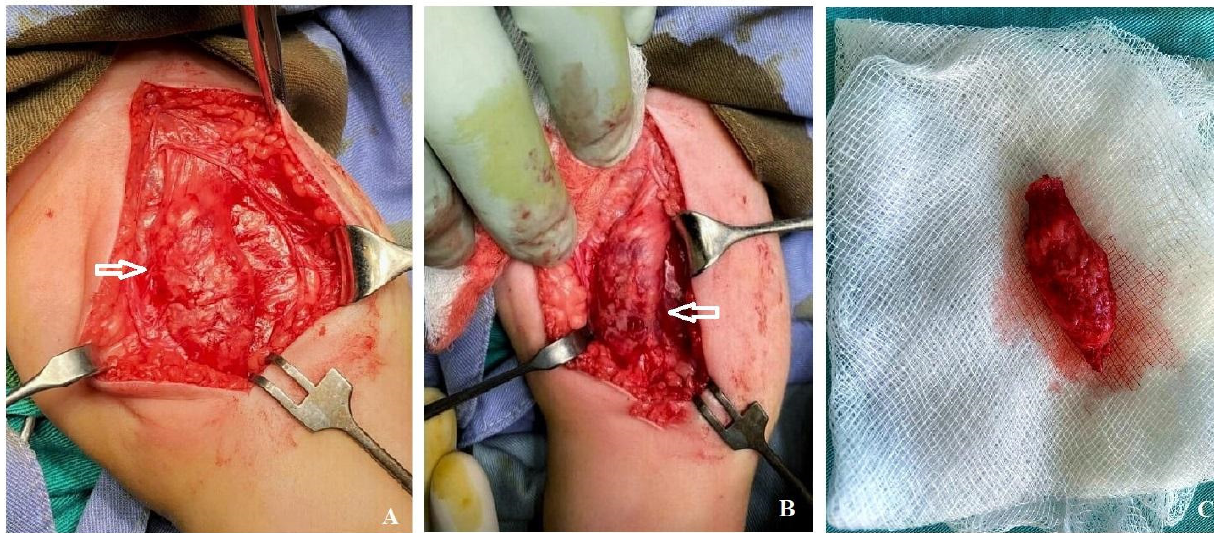
Figure 3. ( A ) Intraoperative aspect of the tumor. Note that the lesion includes the entire thickness of the sartorius muscle (arrow). ( B ) Tumor in the crural fascia that highlights an approximately 4 cm × 1.5 cm × 1.5 cm lesion which includes the entire thickness of the sartorius muscle (arrow). ( C ) Sartorius muscle resected at a distance of about 2 cm distal and proximal to the tumor, with complete tumor resection.